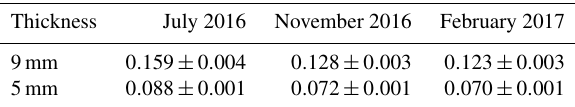
Table 1. Mean values and SDs (standard deviations) of the mea- sured opacity for the two used delrin sheets during different sea-